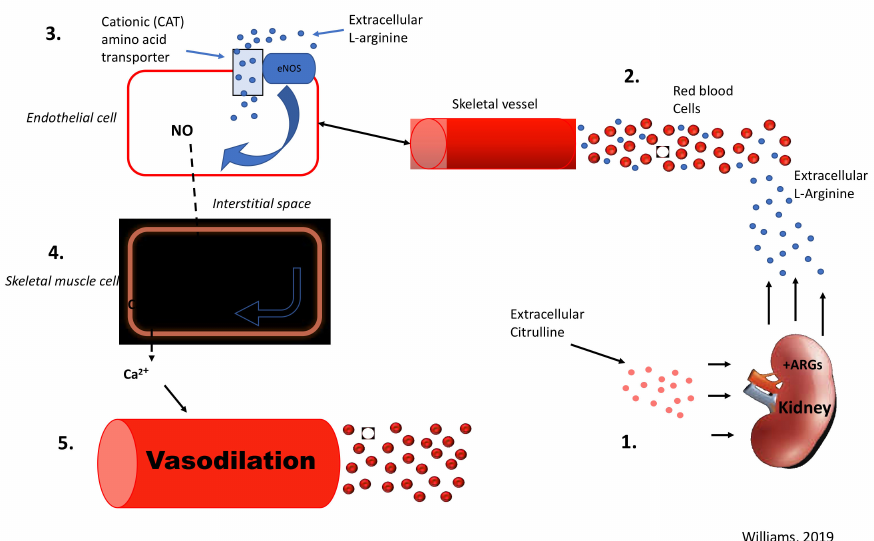
Figure 1. L-Arg, L-Cit and their role in vasodilation. Step 1. Citrulline in systemic circulation is metabolized in the kidneys by ARGs to form L-arginine. Step 2. L-arginine is released systemically into blood vessels. Step 3. L-arginine is transported into endothelial cells via CAT transporters and eNOS to produce nitric oxide (NO). Step 4. NO di ff uses from endothelial cells into skeletal cells. Step 5. NO presence and activation of GC and GTP produces cGMP causing cellular calcium e ffl ux, leading to vasodilation. Abbreviations; ARGs = arginosuccinate synthase; CAT = cationic amino acid transporter; eNOS = extracellular nitric oxide synthase; NO = nitric oxide; GTP = guanosine triphosphate; GC = guanylyl cyclase; cGMP = cyclic guanosine monophosphate. Figure 1 was provided as a courtesy by Mr. Jackson